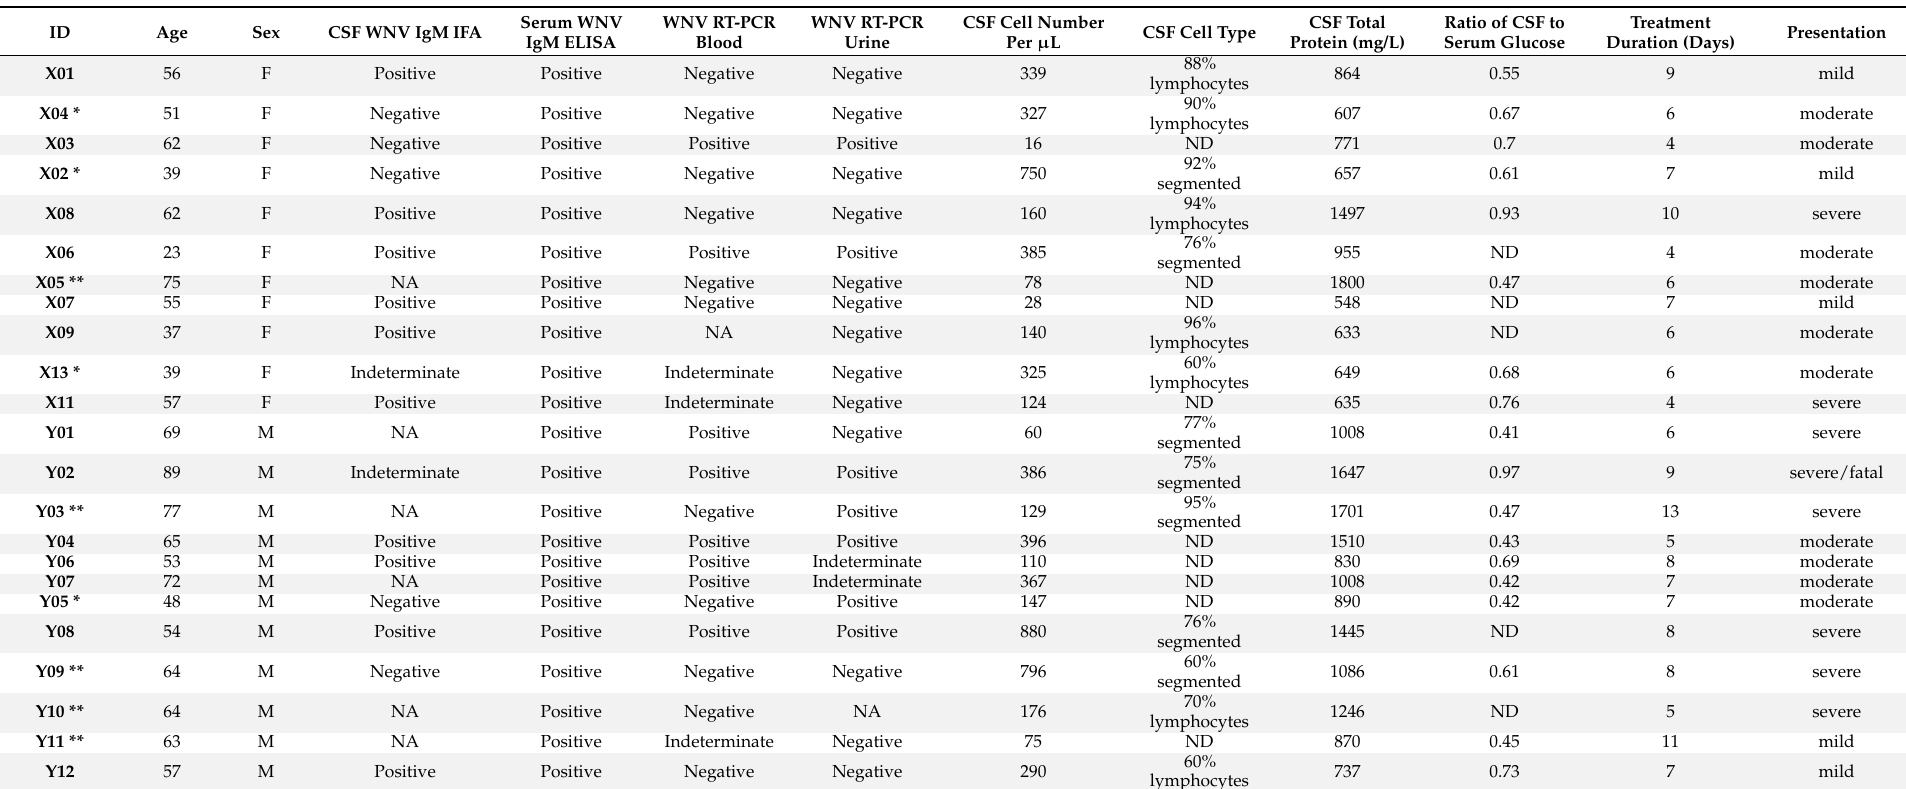
Table 1. Case index and summary of CSF findings and serology results. Single asterisk (*) denotes anti-WNV IgG seroconversion was detected in paired sera, while double asterisk (**) denote probable acute WNV infection in accordance with the clinical picture. IFA—indirect immunofluorescence assay, NA—not applicable, ND—not determined. Indeterminate WNV real-time RT-PCR result was determined by a cycle threshold value >40.00. Presentation was considered as: “mild” if symptoms were limited to flu-like, fever, headache, body aches and rash; “moderate” if mild symptoms in addition to significant impairment of CNS functions, muscle tone were present; or “severe” if any of the above in addition to altered mental status, pneumonia, status epilepticus, hemiparesis, or pulmonary embolism